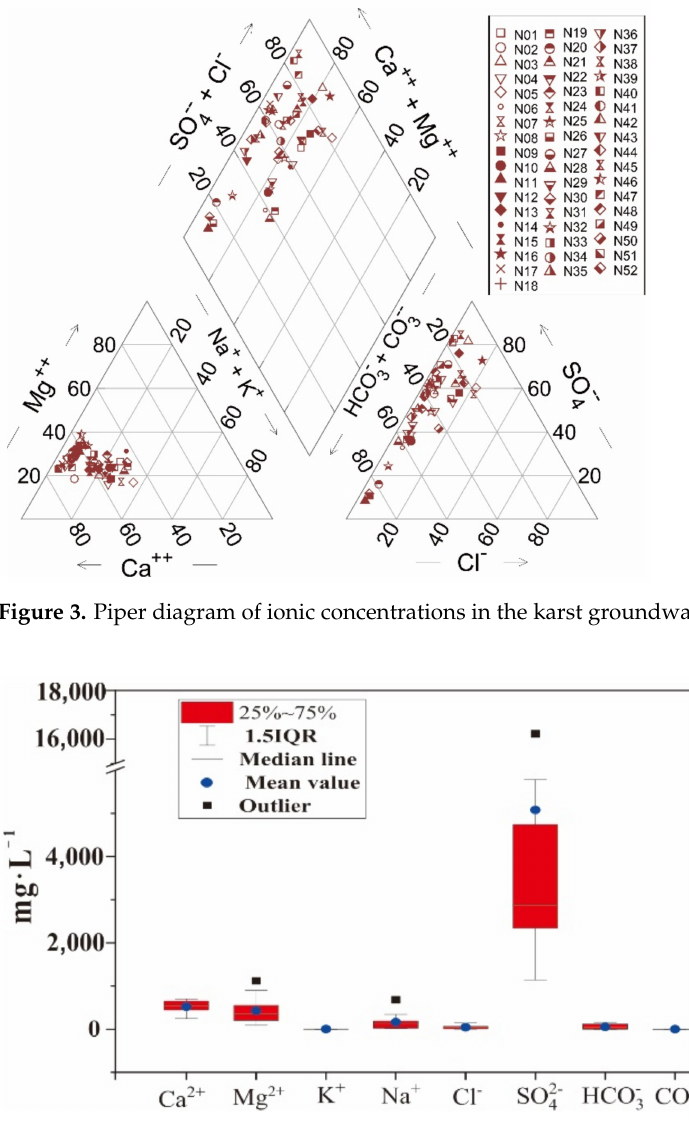
Figure 4. Box chart of ionic concentration in Acidic Mine Drainage (AMD).